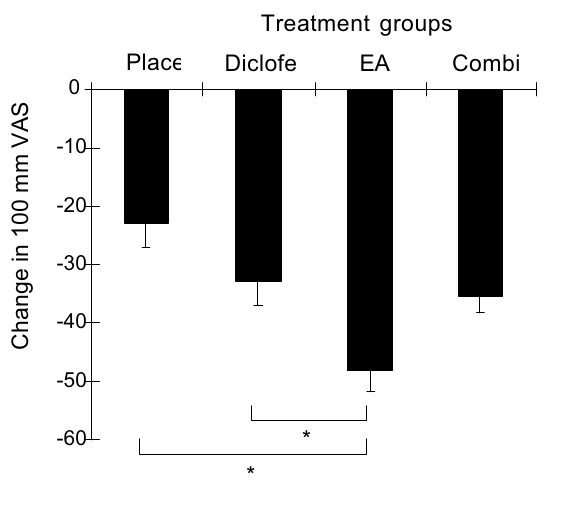
Figure 3 Change in Lequesne's functional index in each treatment group evaluated at the end of week 4. Values are mean ± SEM. * = p < 0.05 between groups (one-way ANOVA and Scheffe